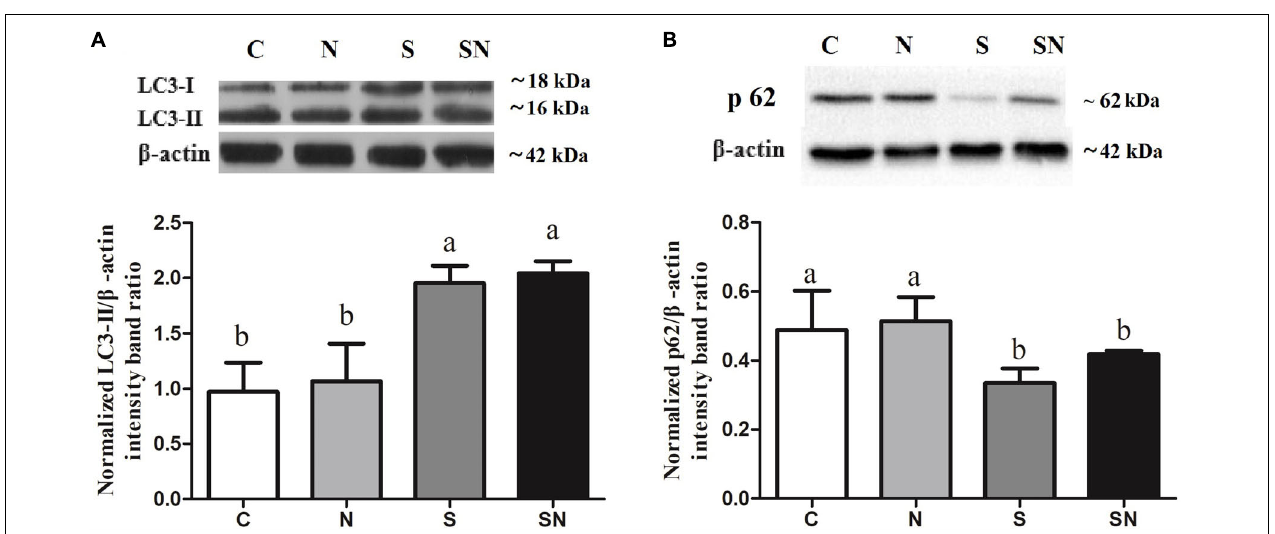
FIGURE 6 | Effect of Fe 3 O 4 -NPs on LC3 (A) and p62 (B) protein expression in the livers of chickens exposed to Fe 3 O 4 -NPs in the absence or presence of S . Enteritidis administration. Values represent the mean ± SEM. Different letters indicate statistically significant